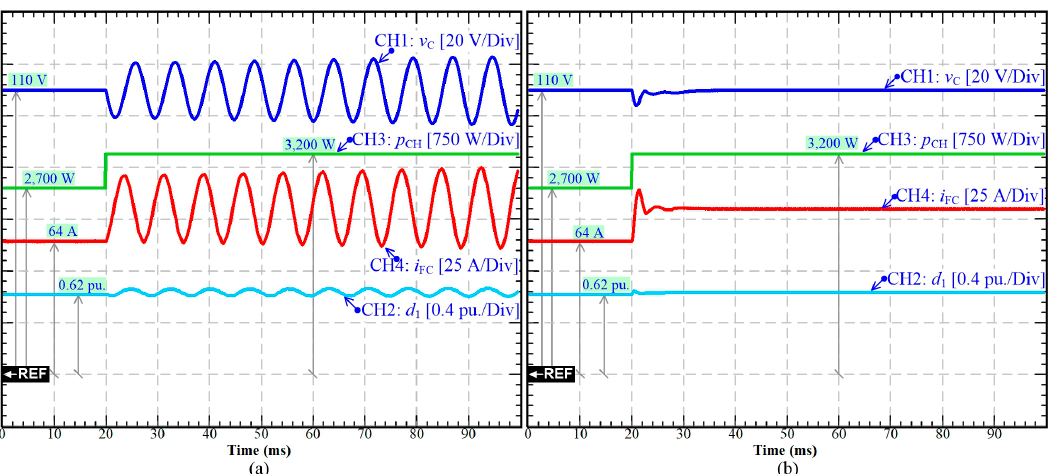
Figure 14. Simulation results: Dynamic behavior of the FC converter during a CPL step: 2000 W to 2500 W: ( a ) linear PI control law; ( b ) proposed adaptive Hamiltonian PI control law.